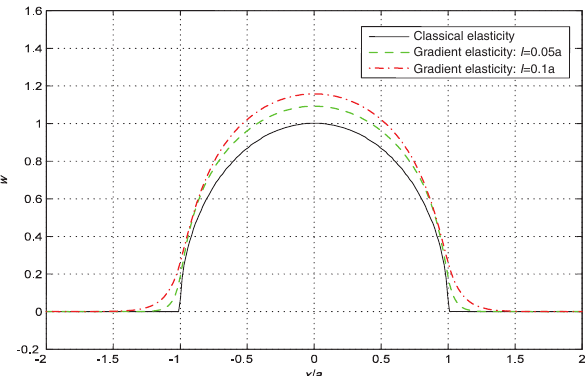
Figure 7: Crack opening displacement for classical and gradient